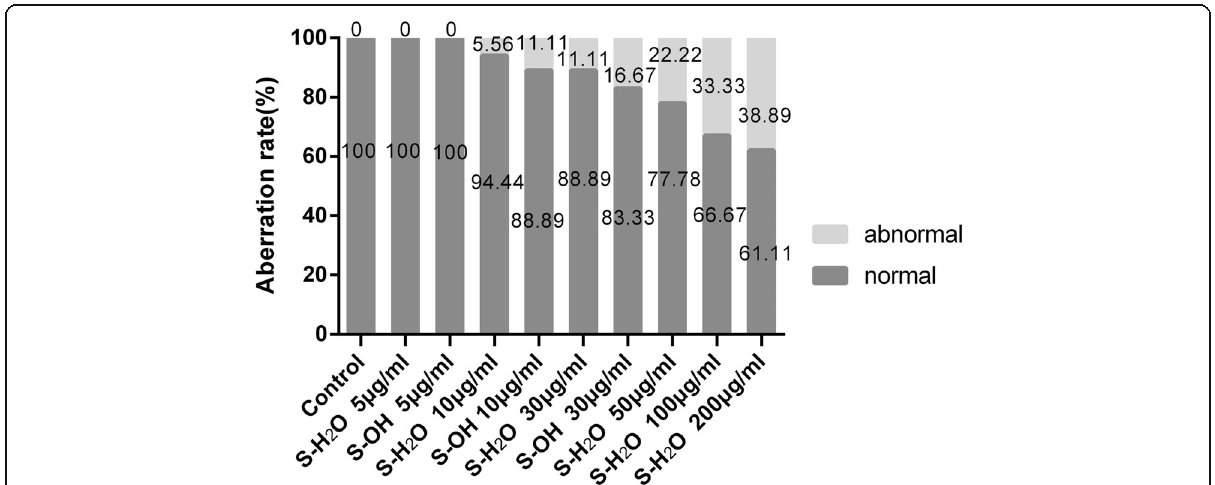
Fig. 2 The percentage of morphologically abnormal and normal zebrafish treated with different concentrations of S.fru-OH or S.fru-H 2 O compared to the control ( n = 18 per